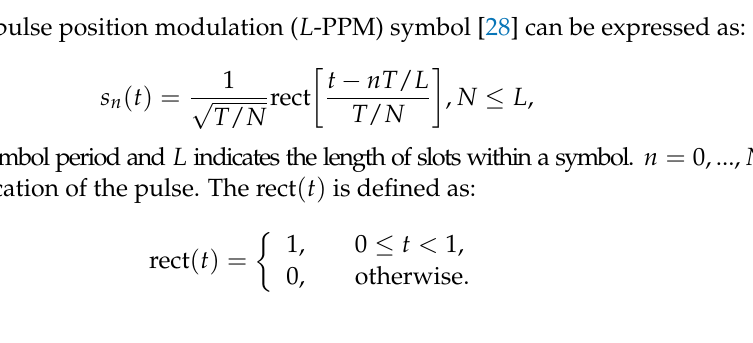
Figure 2. Structure of the integrated system for deep-space optical measurement and